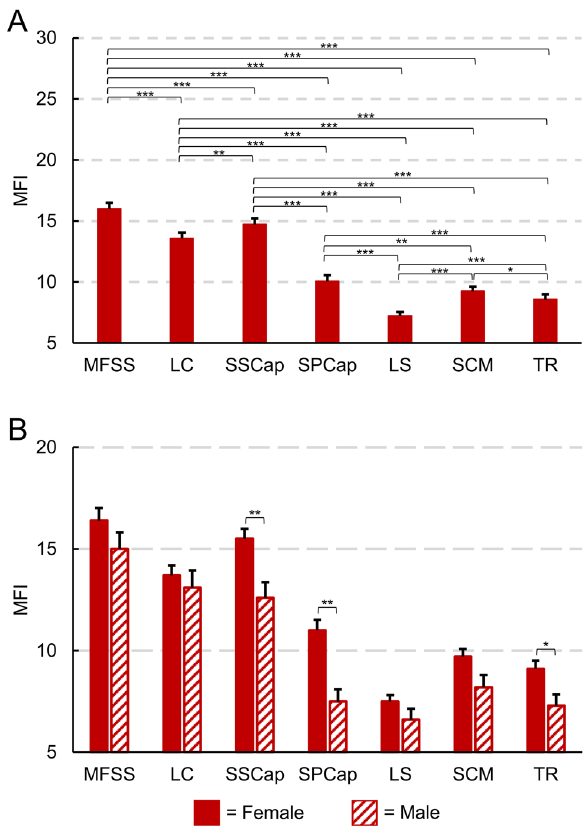
Figure 5. Muscle fat infiltration (MFI) of each muscle was calculated from the convolutional neural network (CNN) segmentations in 84 participants from the first time point (< 2 weeks following a motor vehicle collision, 61 females, 23 males, age = 34.2 ± 10.7 years). The left and right MFI measures for each muscle group were averaged for these analyses. ( A ) Between muscle group comparison of MFI. Each muscle group had significantly different MFI (paired t-tests) with the deep cervical extensors and flexors having higher MFI than the more superficial layers. ( B ) MFI by sex for each muscle group. When averaging across all muscle groups, female participants had significantly greater MFI than male participants (1.8% ± 0.8% higher MFI in females, p = 0.026). Females had significantly higher MFI than males in the SSCap, SPCap, and TR (one-way ANCOVA